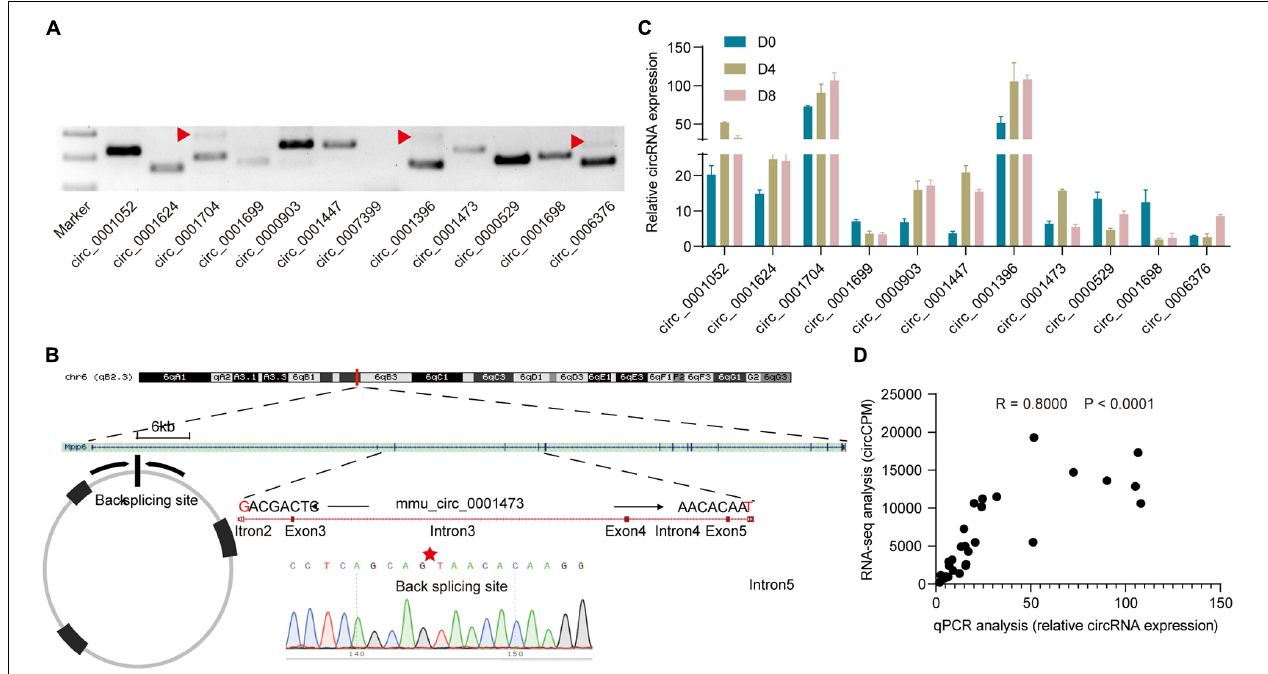
FIGURE 2 | Verification of circular RNAs. (A) Electrophoretic band of circRNAs. The red triangle represents double-size products. (B) Representative Sanger sequencing results of circRNAs. The red star represents the back-splicing site. (C) Relative circRNA expression levels detected by qPCR ( n = 3). (D) Correlation analysis of qPCR results and RNA-seq